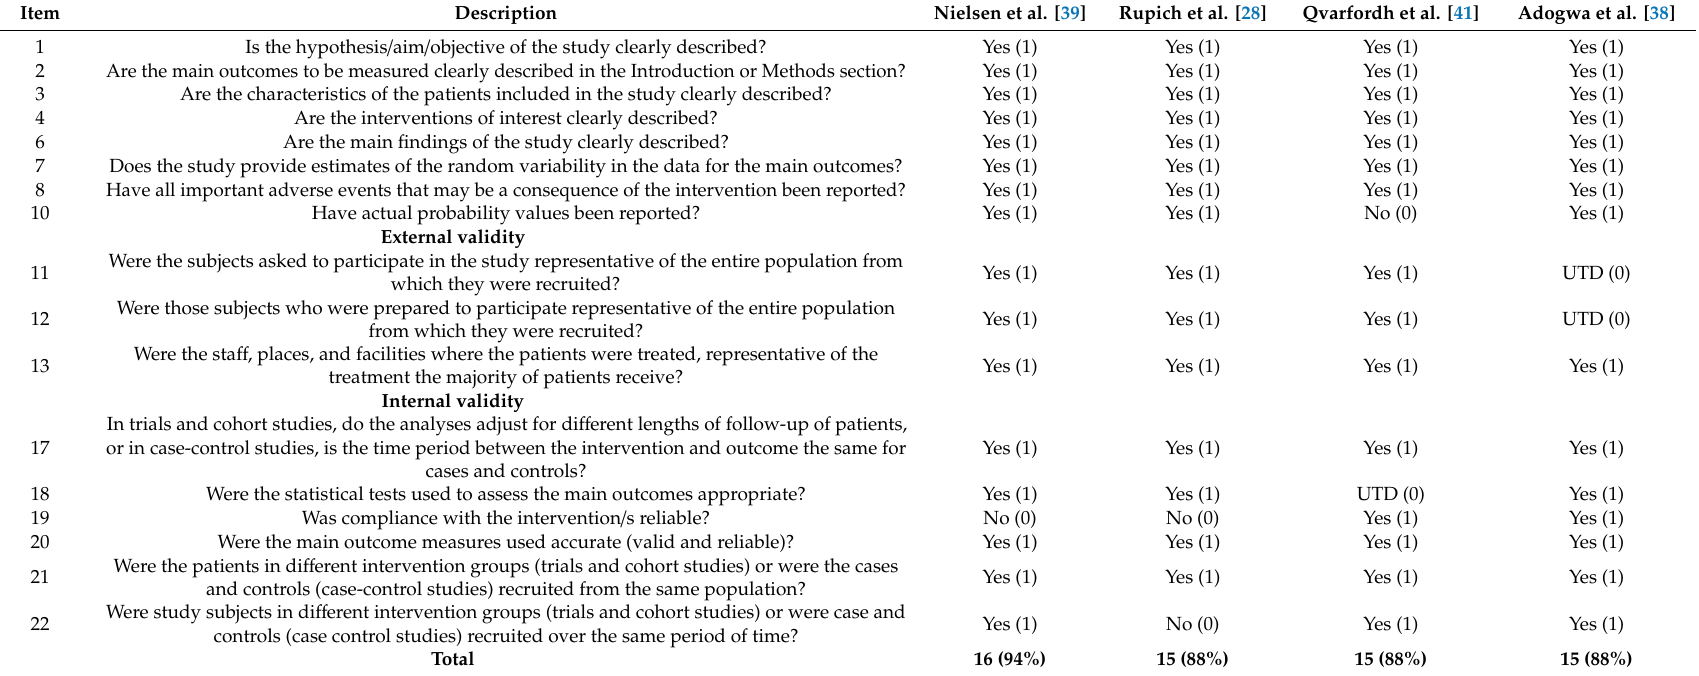
Table A1. Modified Downs and Black Checklist, UTD—Unable to